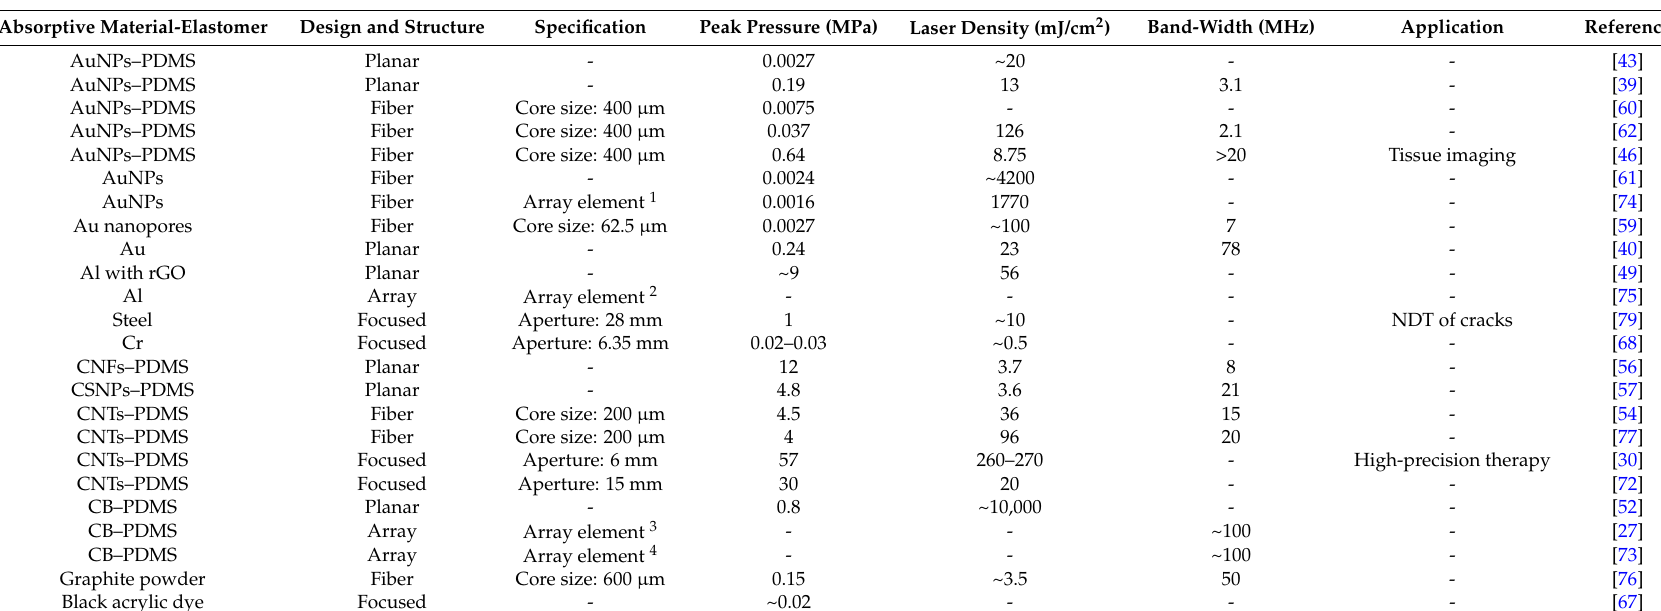
Table A1. Summary of the characteristics of laser-generated ultrasound transmitters, AuNPs: gold nanoparticles; CB: carbon black; CNFs: carbon nanofibers; CNTs: carbon nanotubes; CSNPs: candle soot carbon nanoparticles; NDT: nondestructive testing; PDMS: polydimethylsiloxane; rGO: reduced graphene oxide. Absorptive